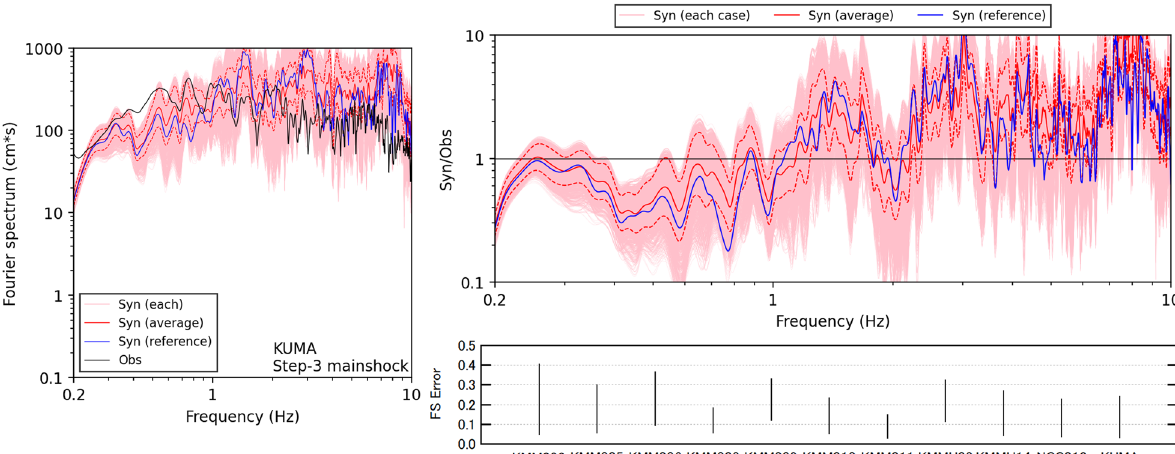
Fig. 14 Variation of the predicted Fourier spectrum at KUMA for the mainshock. (Left) Pink lines indicate the synthetic Fourier spectra of cases that showed better average FS errors than the reference case. The red line indicates the geometric mean of pink lines. The blue line indicates the synthetic Fourier spectrum of the reference case. The black line indicates the observed Fourier spectrum. (Upper right) Pink, red, and blue lines indicate the spectral ratios of the corresponding lines in the left panel to the observed spectrum. (Bottom right) Black lines indicate the ranges of FS error at each